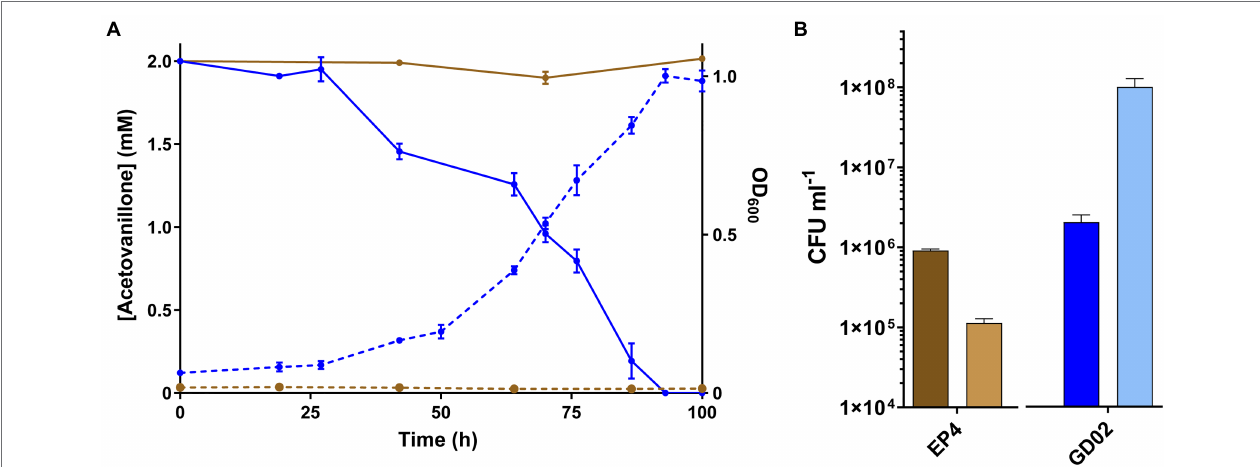
FIGURE 2 | Growth of GD02 on acetovanillone. (A) GD02 was grown in M9 minimal medium with 2 mM acetovanillone at 30 ° C. Solid lines represent concentration of acetovanillone as determined using GC-MS, and dashed lines represent OD 600 . Blue and brown lines represent data for GD02 and EP4, respectively. (B) CFU ml − 1 at 0 h (dark) and 100 h (light). Data points show average of triplicate experiments and the vertical bars the SD.